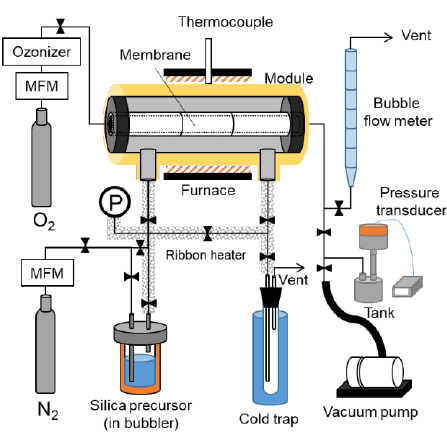
Figure 3. Counter di ff usion CVD- gas permeation apparatus.